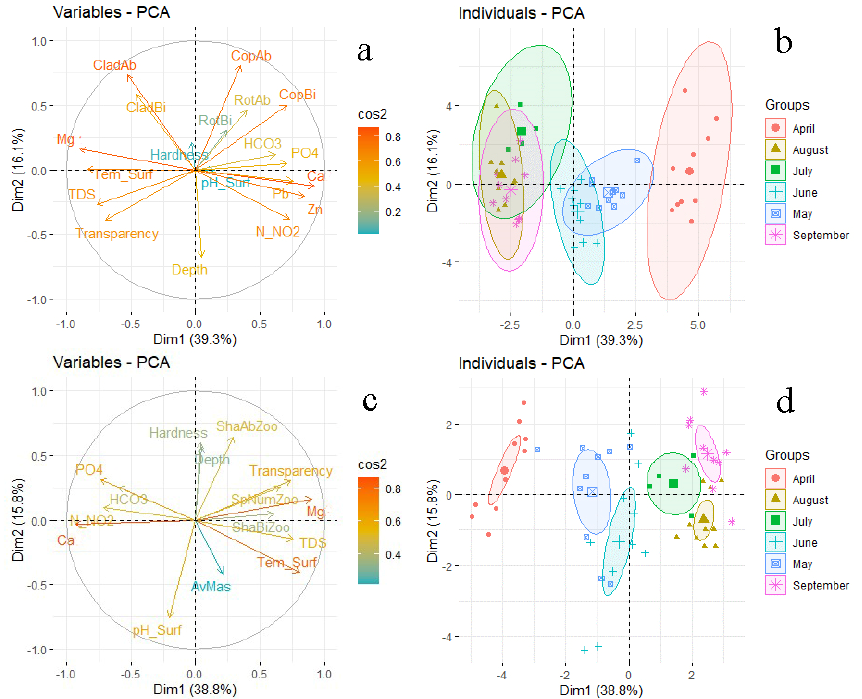
Figure 9. Principal component analysis (PCA) biplot of relationships between environmental and biological variables in zooplankton communities of Sorbulak, 2021: relationship between environmental and quantitative variables ( a ), distribution of environmental and quantitative variables by